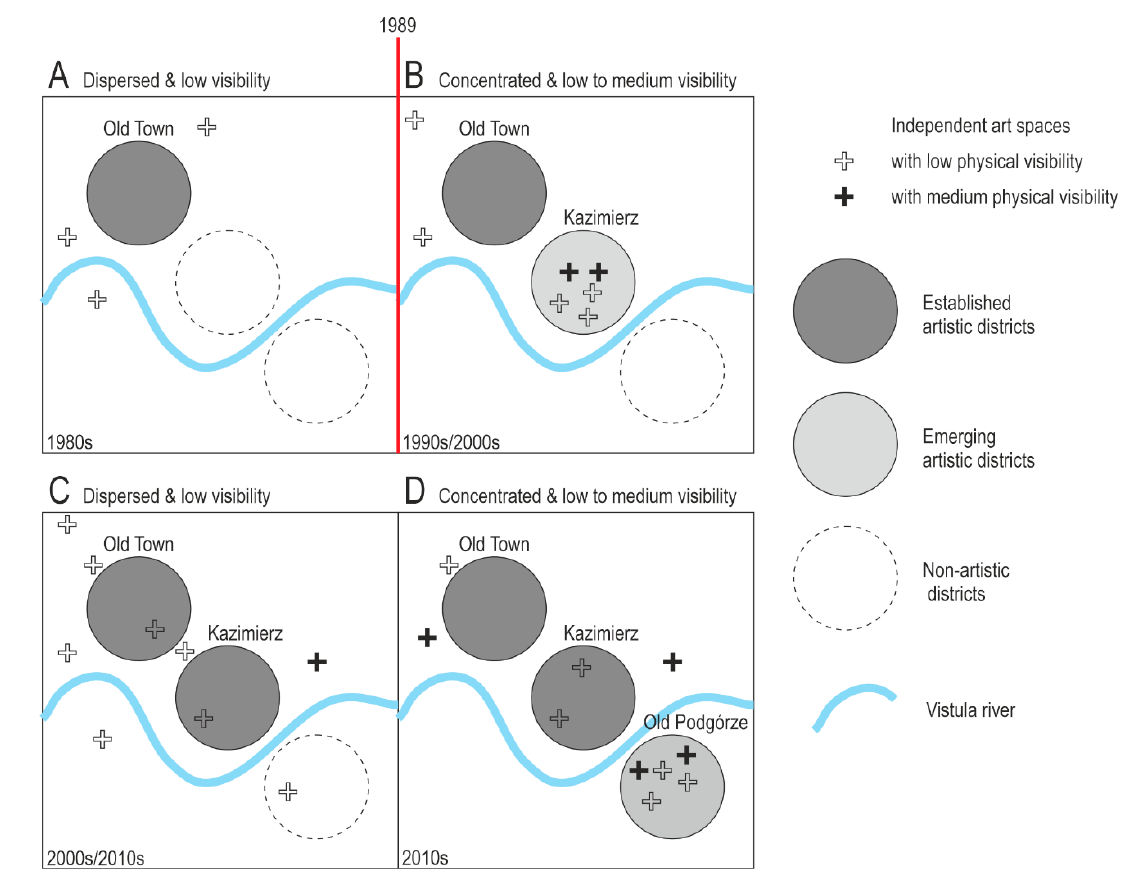
Figure 2. Model of the spatial history of independent art spaces in Krakow. Source: own study.